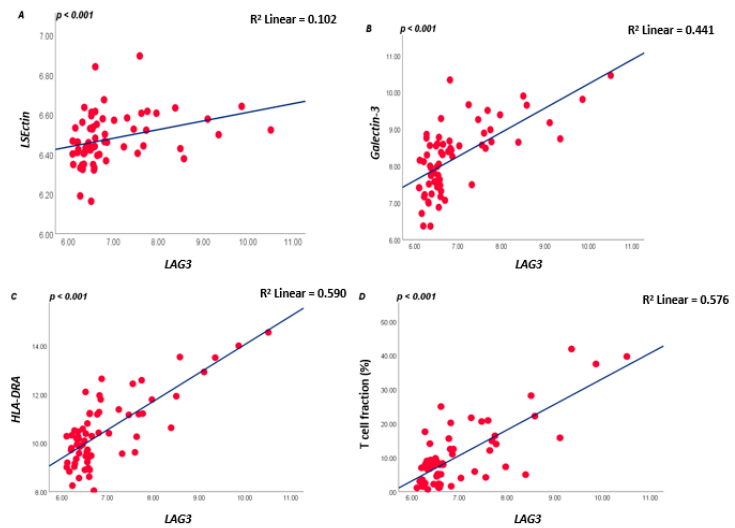
Figure 2. Correlation between LAG3 , LSECtin , Galectin-3 , and HLA-DRalpha in the 64 UM cohort from Leiden ( A – C ), and between LAG3 and lymphocyte fraction as determined by ddPCR ( D ); a Spearman correlation was applied. p ≤ 0.05 is considered significant.